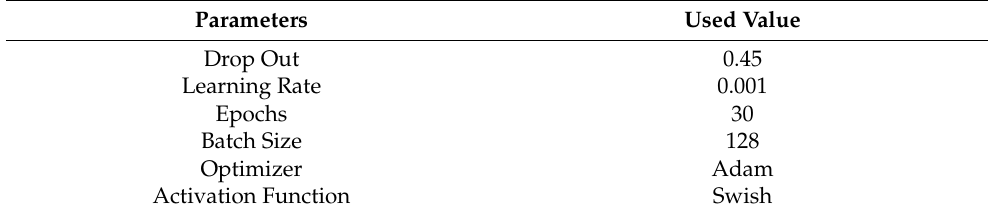
Table 4. Parameters used in the proposed